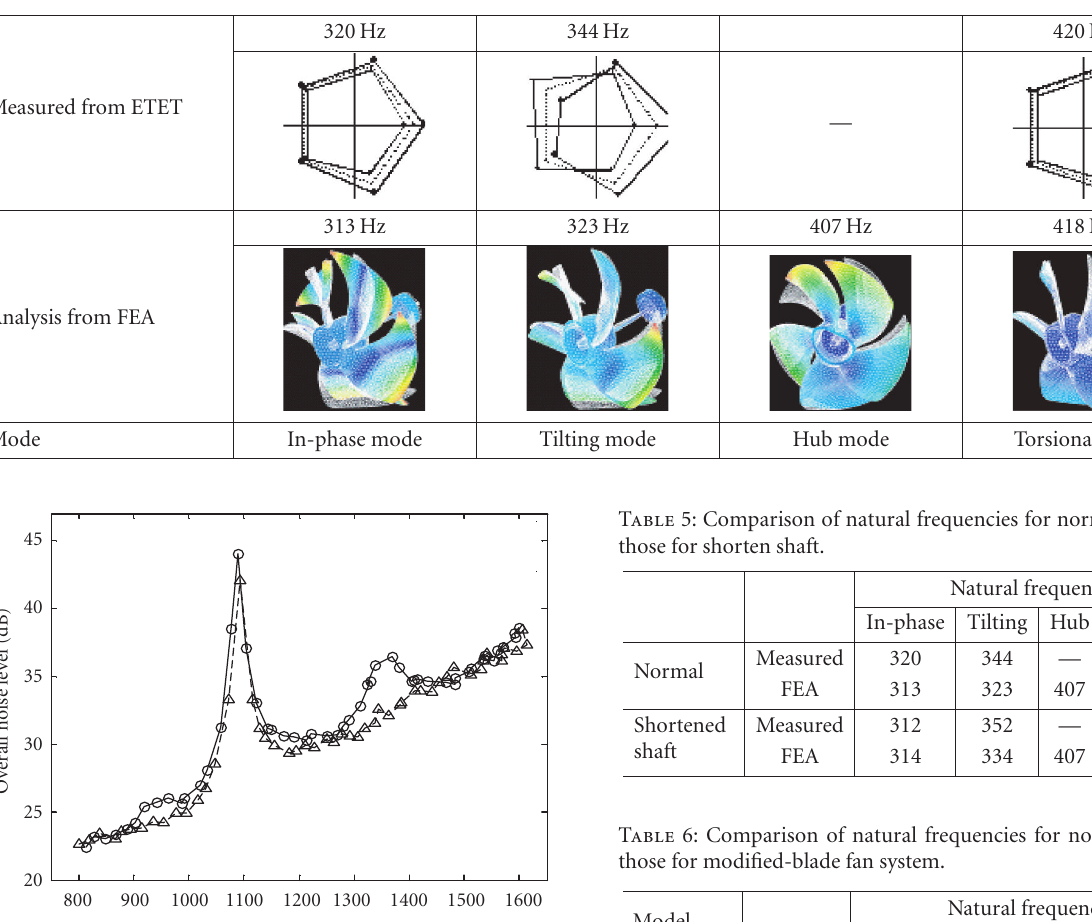
Table 4: Pairing of mode shapes from ETET with those from FEA.